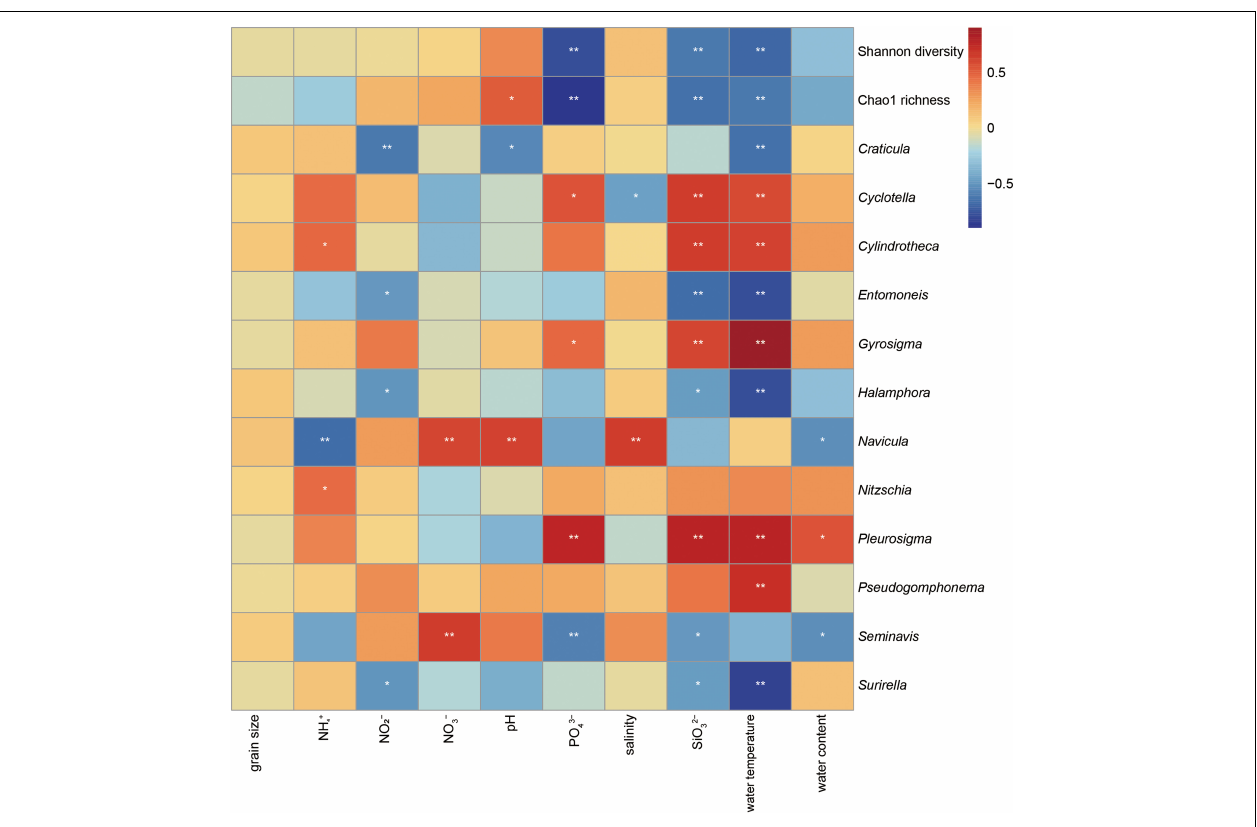
FIGURE 6 | Heatmap of the correlation between the dominant benthic diatom taxa as well as diversity and environmental factors in the Yellow River Delta. Spearman correlation coefficient was displayed by the color of each cell in the heatmap. A significant correlation was confirmed if the p -value was less than 0.05 (*) or 0.01